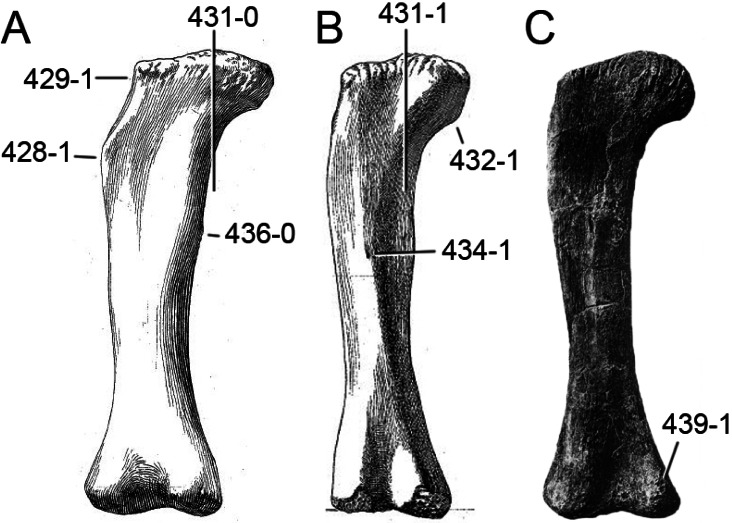
Neosauropod femora.Right femur of Giraffatitan brancai MB.R.2694 (A), Dicraeosaurus hansemanni MB.R.4886 (B; both modified from Janensch, 1961), and Tornieria africana SMNS 12140 (C; modified from Fraas, 1908) in anterior view. Note the lateral bulge (A; C428-1), the medial deflection of the femoral head (A; C429-1), the different positions of the highest point of the femoral head (C431), the stepped ventral margin of the head (B; C432-1), the nutrient foramen (B; C434-1), the fourth trochanter, which is visible in anterior view (A; C436-0), and the anteriorly extended distal articular surface of the condyle (C; C439-1). Scaled to same length.